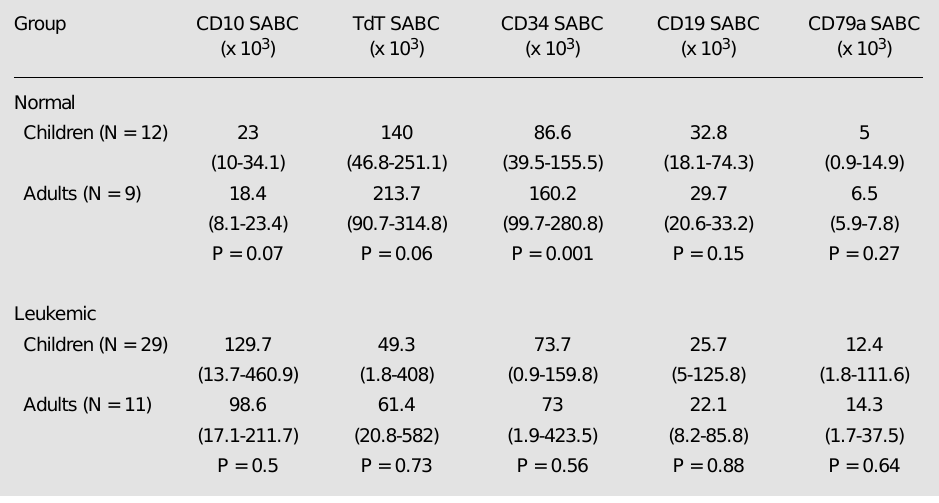
Figure 2 - Two-dimension plot showing the age-related changes in the expression of CD10, CD19, TdT, CD34 and CD79a. The age in years is represented on the Z-axis and the specific antibody binding capacity (SABC) values of CD10/CD19 (A), CD10/ TdT (B), CD10/CD34 (C) and CD10/CD79a (D) markers are shown on the X- and Y-axis, re- spectively. The SABC values of the normal subjects are repre- sented by crosses and those of the CD10 + acute lymphoblastic leukemia cases by